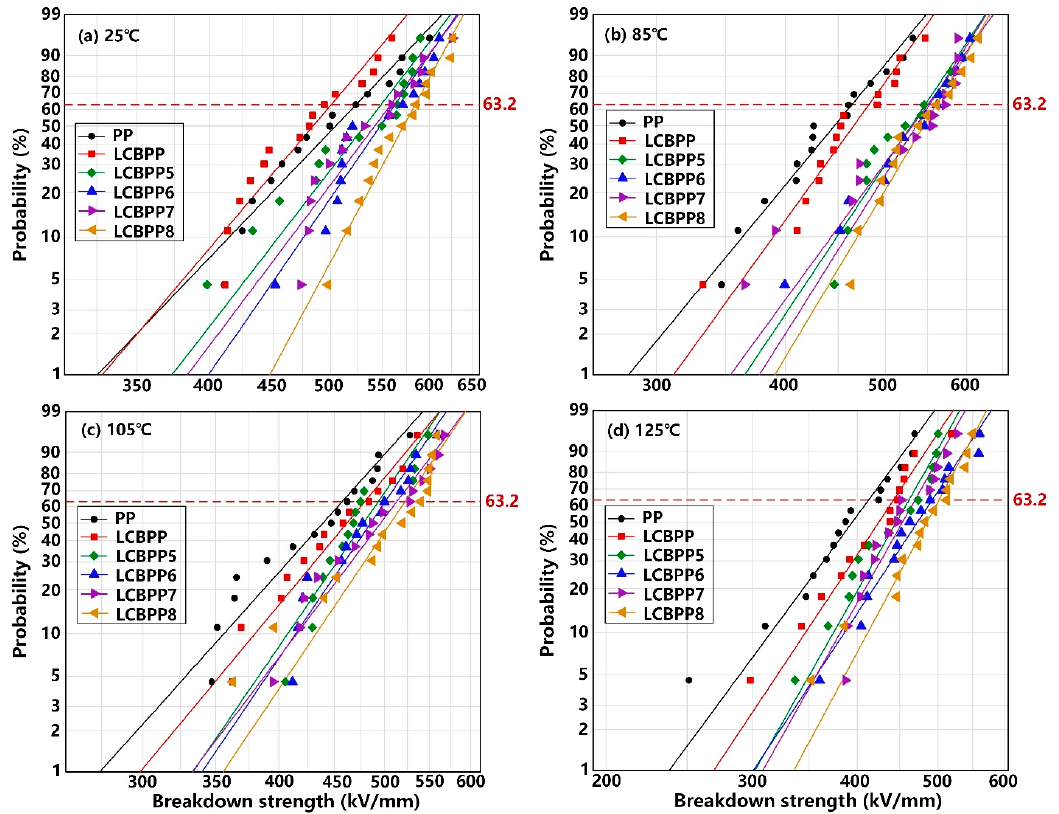
Figure 12. Relation between the breakdown strength and the β nucleating agents at different tem- peratures.